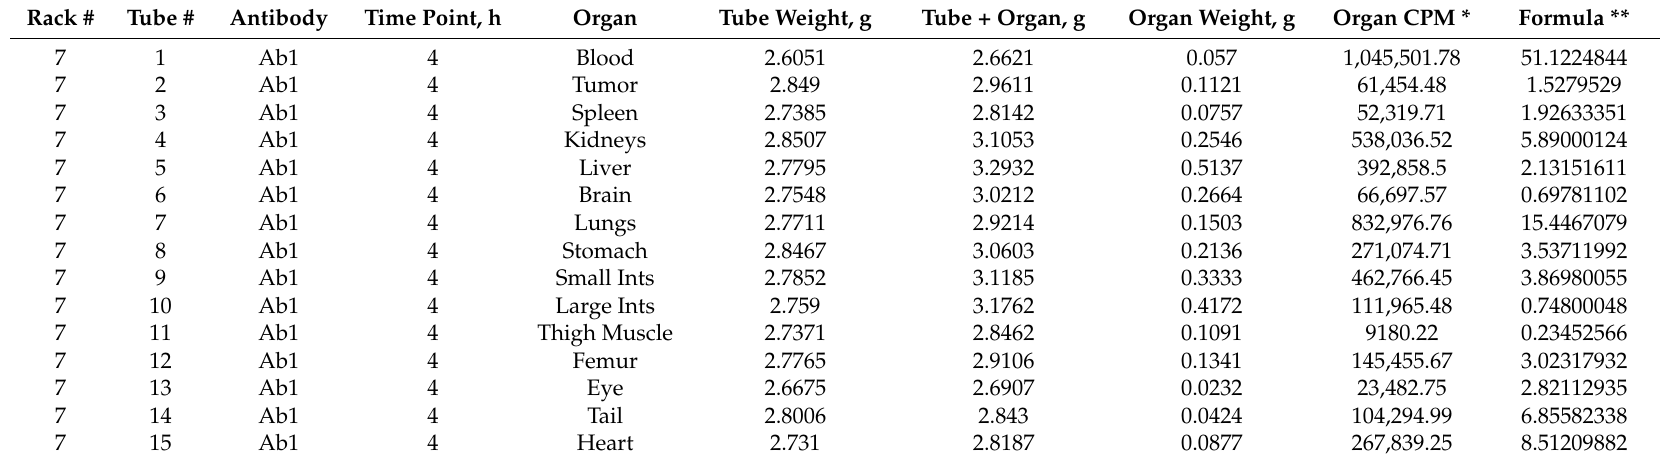
Table 1. Example of the raw data and the calculated uptake of the 111 In-Ab1 into the organs/tissues at 4 h post administration to mice.